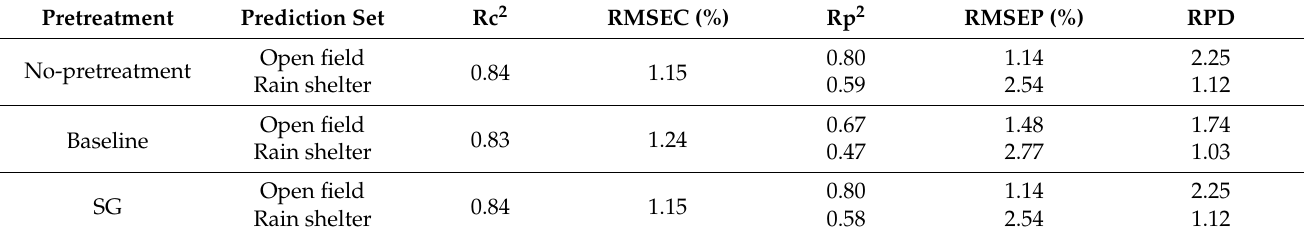
Table 3. Prediction results of SSC using different pre-processing methods.